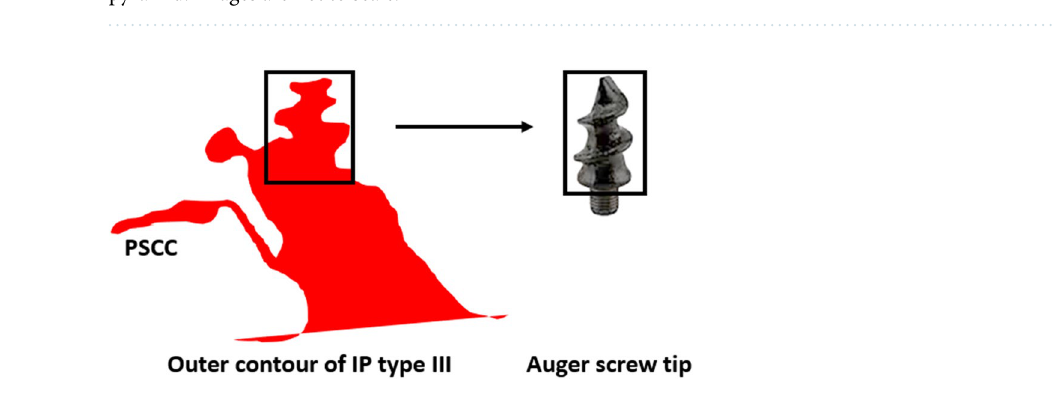
Figure 6. Mid-modiolar section of incomplete partition (IP) type I resembles the side view of the Sphinx pyramid. Images are not to scale.